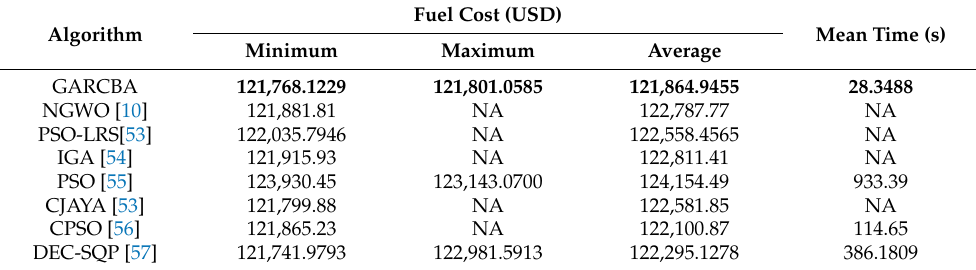
Table 12. Statistical results for Case